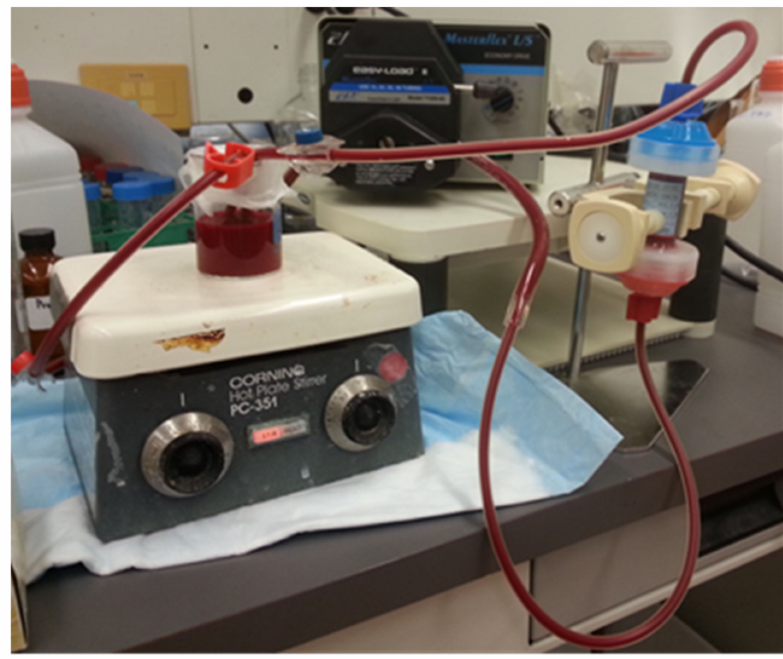
Figure 4. Simulation of extracorporeal LPS removal via a “baby” cartridge. The PMB-immobilized fiber column was first removed from the “baby” cartridge and then submerged in the prepared proteinase K buffer solution (100 µ g/mL, 10 mL) at 37 ◦ C for 12 h. The fiber column was then removed from the proteinase K solution, gently rinsed with 0.9% sodium chloride irrigation to remove any remaining solution and inserted back into the original “baby” cartridge. A Masterflex pump system was used to maintain circulation of blood at a flow rate of 80 mL/min. 80 mL of Whole blood was spiked with 170 µ g FITC-LPS and was then perfused over the “baby” cartridge containing the proteinase K-treated fiber column for 90 min at room temperature. Two tubes of 5 mL blood samples were collected and centrifuged at 2500 rpm for 15 min. The plasma